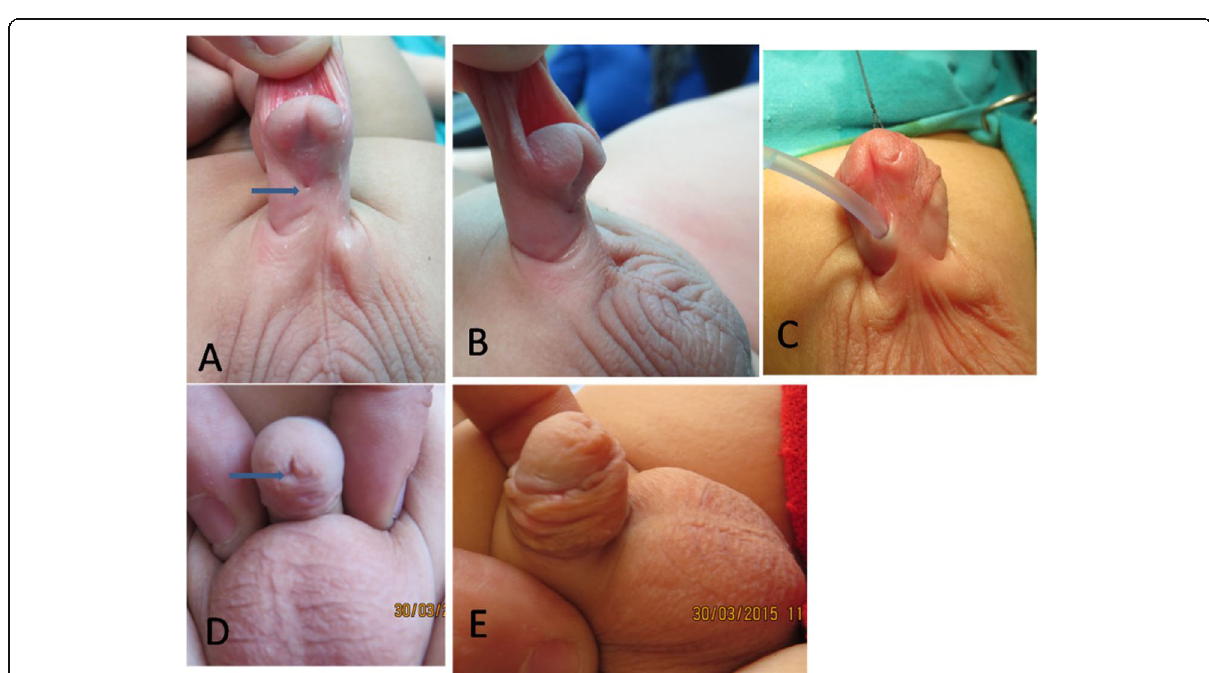
Fig. 2 12-month-old boy with mid penile hypospadias from the ‘ untreated ’ group (group B). a Preoperative appearance demonstrating the hypospadiac position of the meatus (arrow). b Lateral view. c Catheter passing through meatus. This case was operated by one stage TIP repair without preoperative hormonal therapy. d and e Follow up 6 months after surgical repair demonstrating satisfactory